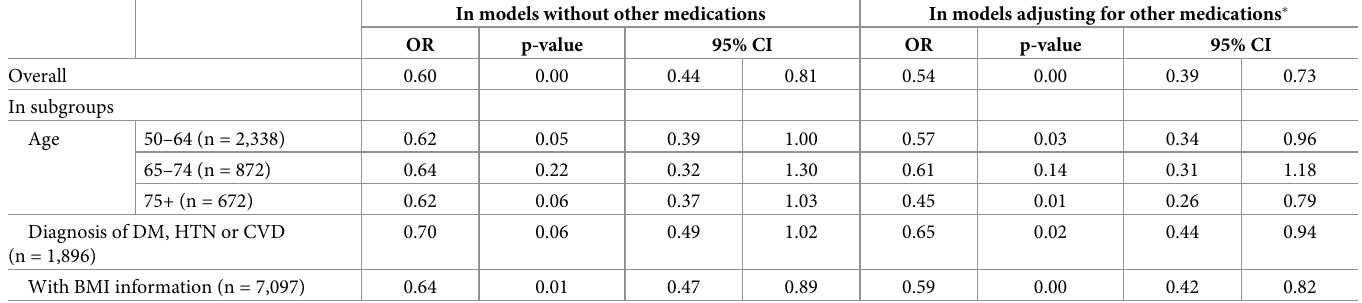
Table 3. Sensitivity